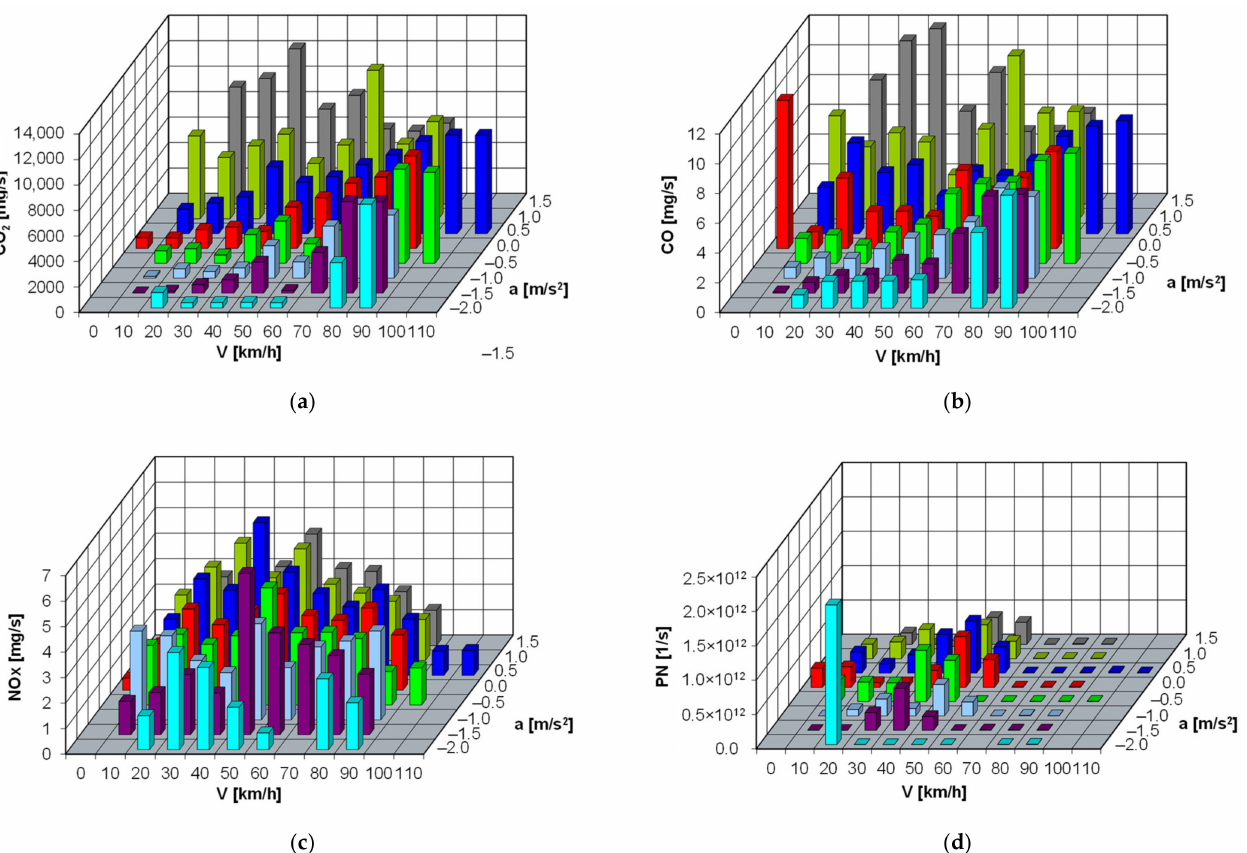
Figure 15. Two-dimensional distribution of flow rate of CO 2 ( a ), CO ( b ), NOx ( c ) and PN ( d ) in vehicle speed-acceleration coordinates (N2